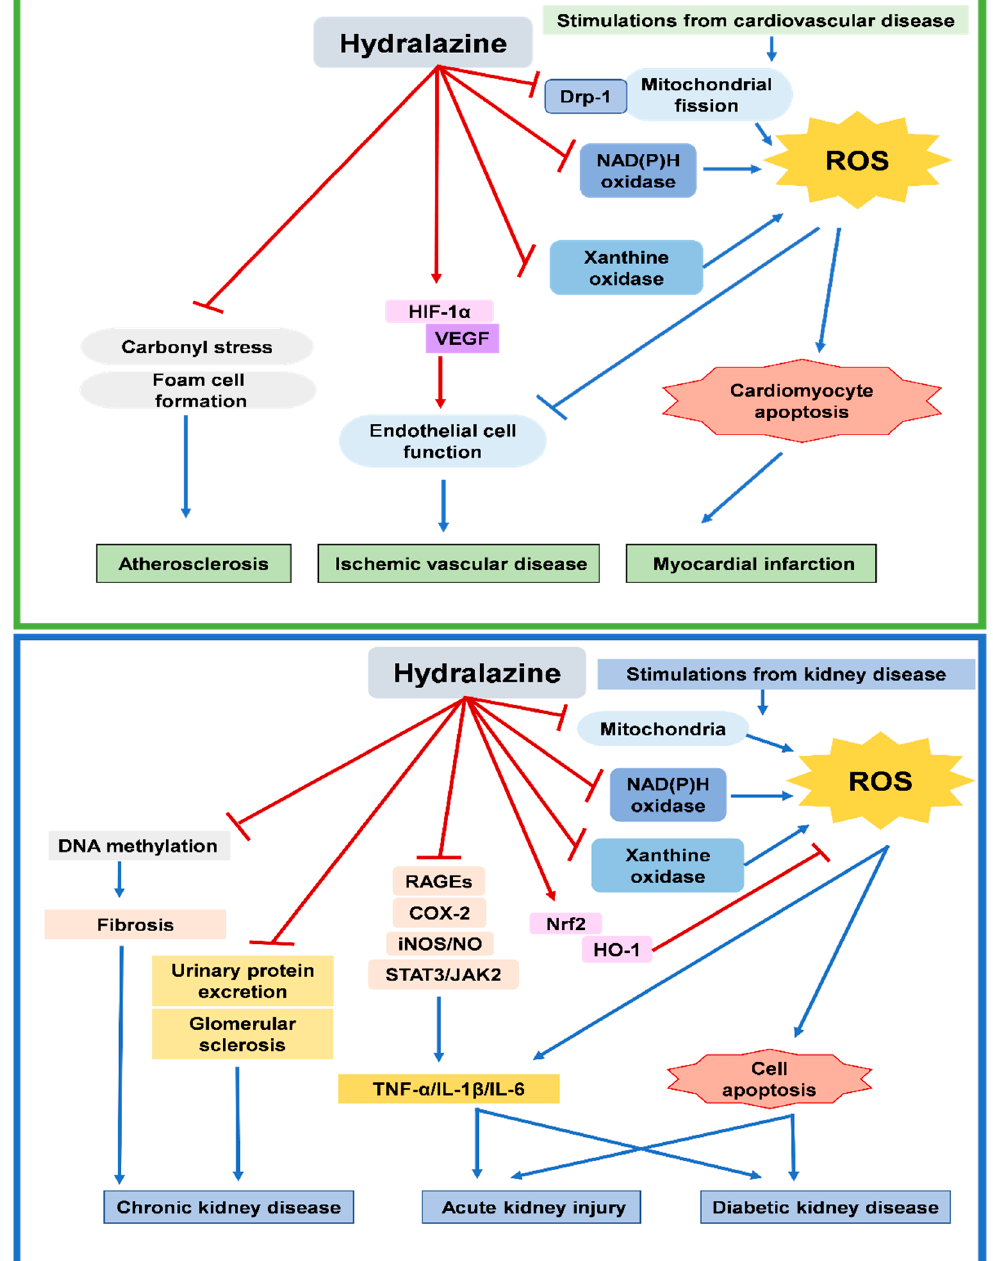
Figure 2. Overview of mechanisms of hydralazine for antioxidation in cardiovascular and kidney diseases. Heme oxygenase 1: HO-1; hypoxia inducible factor 1 α : HIF-1 α ; inducible nitric oxide syn- thase: iNOS; interleukin: IL; vascular endothelial growth factor: VEGF; nitric oxide: NO; nuclear factor erythroid 2-related factor 2: Nrf2; reactive oxygen species: ROS; receptor for advanced gly- cation end products: RAGE; tumor necrosis factor α : TNF- α .